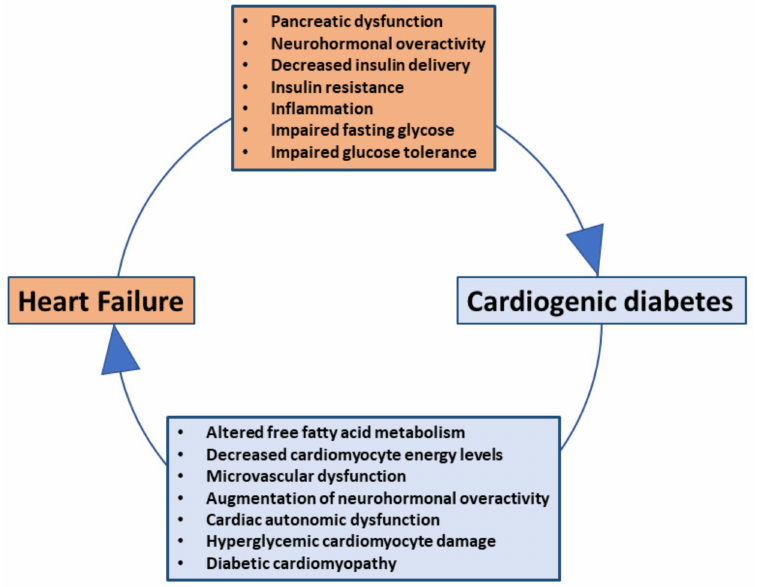
Figure 8. Heart failure (HF) leads to the development of cardiogenic diabetes, which subsequently adversely affects cardiac function and HF